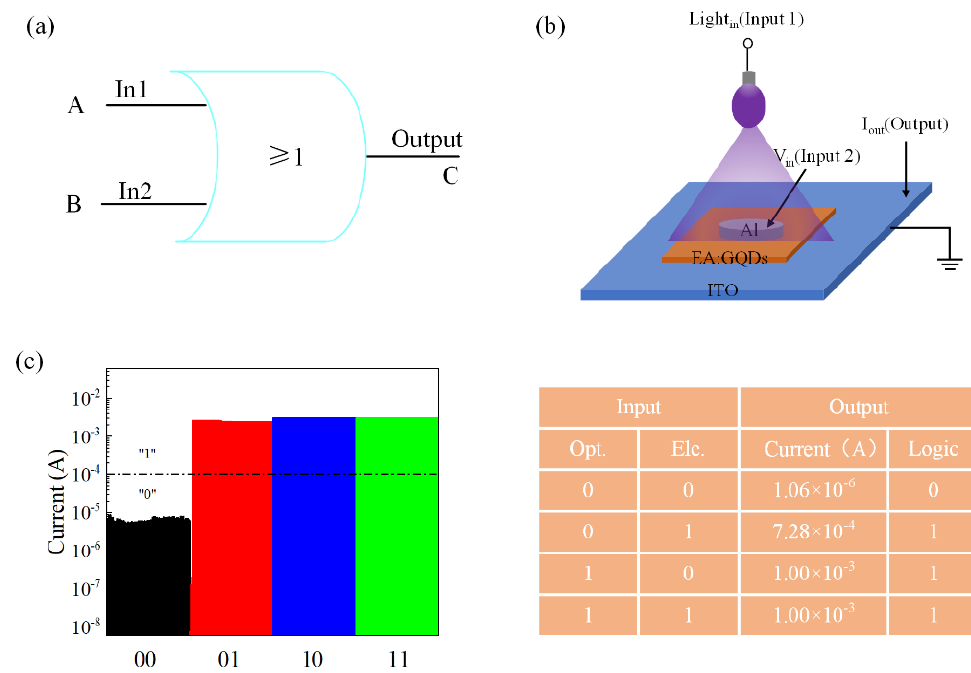
Figure 4. ( a ) OR gate. ( b ) Schematic diagram of applied illumination. ( c ) Current response of the device unit under different input signals.